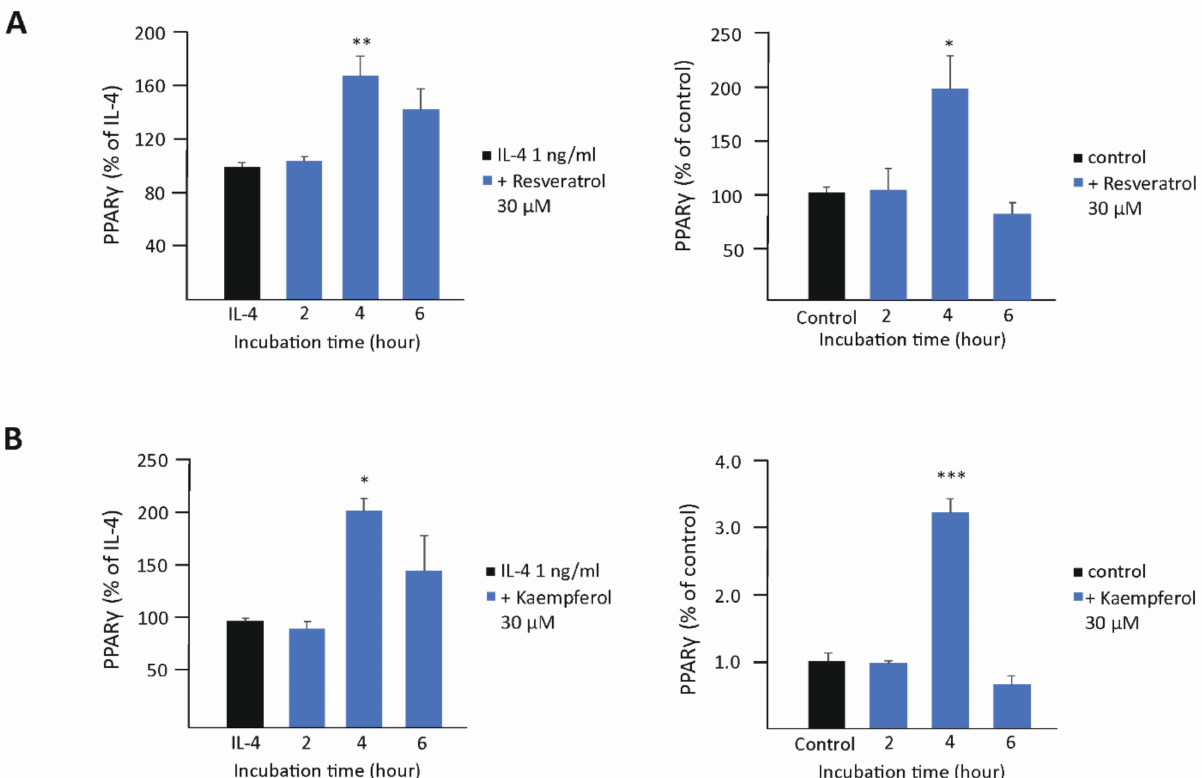
Figure 3. Resveratrol ( A ) and kaempferol ( B ) enhanced the expression of peroxisome-proliferator- activated receptor gamma (PPAR γ ) in murine J774 macrophages cultured with interleukin 4 (IL-4, ( left )) or without IL-4 ( right ). Expression of PPAR γ mRNA was measured by RT-PCR and normalized